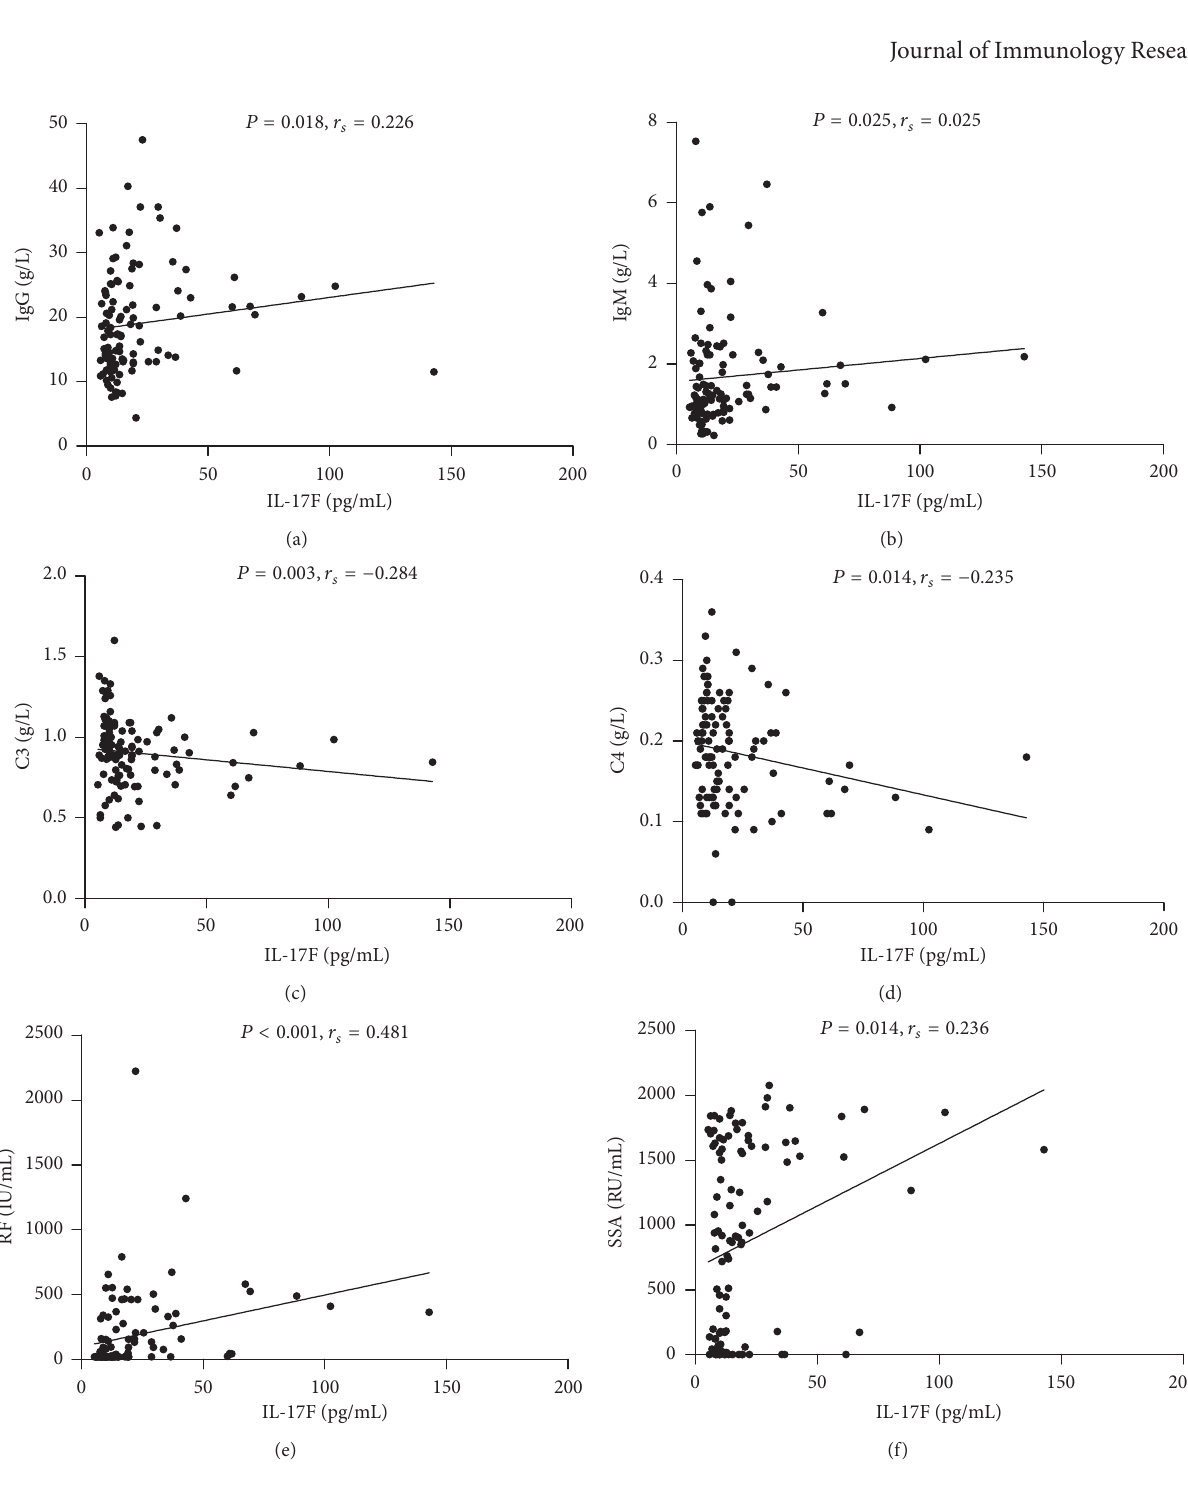
Figure 2: Correlation of serum level of IL-17F with laboratory parameters in pSS patients: (a) IL-17F positively correlated with IgG; (b) IL- 17F positively correlated with IgM; (c) IL-17F negatively correlated with C3; (d) IL-17F negatively correlated with C4; (e) IL-17F positively correlated with RF. (f) IL-17F showed positive correlation with anti-SSA antibody. C3: complement